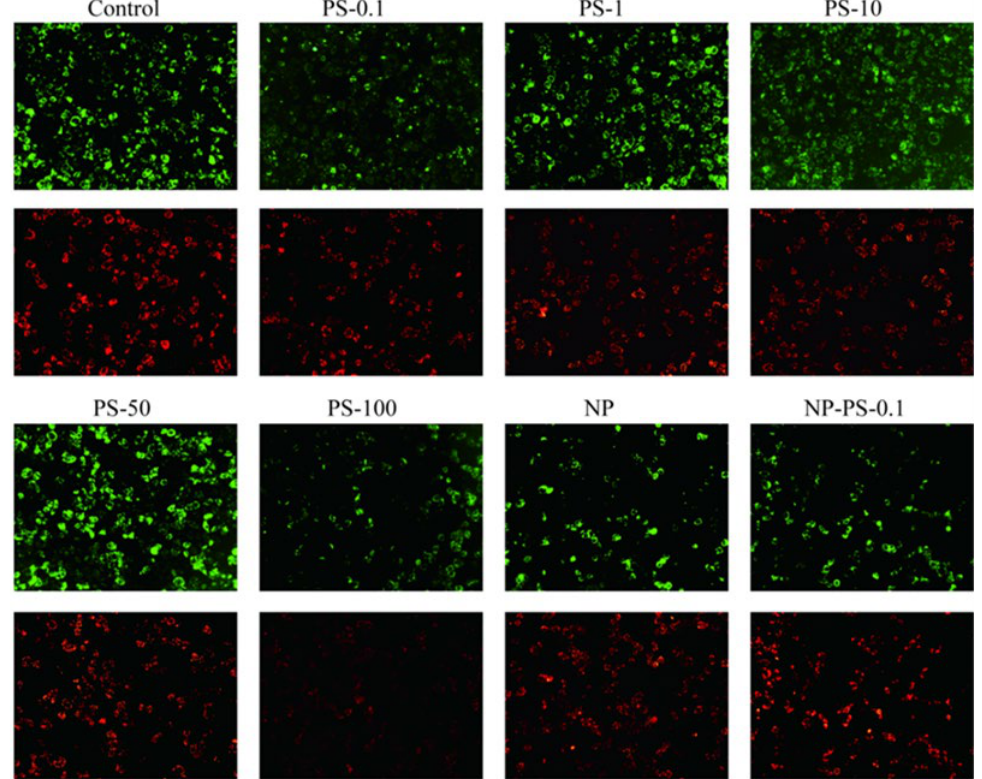
Figure A3. The mitochondrial membrane potential depolarization of Caco−2 cells treated by 40 μmol/L NP, 500 mg/L PS - MPs with different particle sizes, 0.1 μm PS−MPs that absorbed NP at 48 h. Representative photograph from an inverted fluorescence microscope.